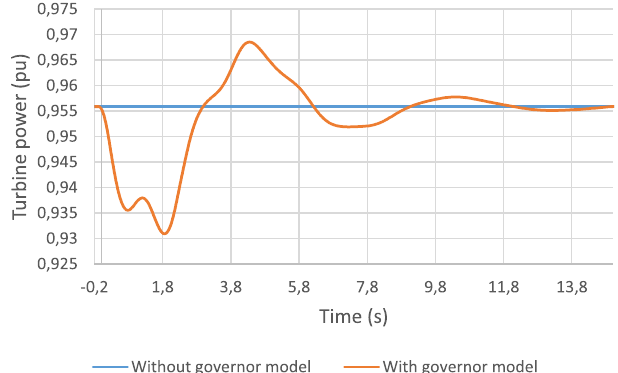
Fig. 5. Evolution of the generator 3 turbine power with and without a governor model regulation.